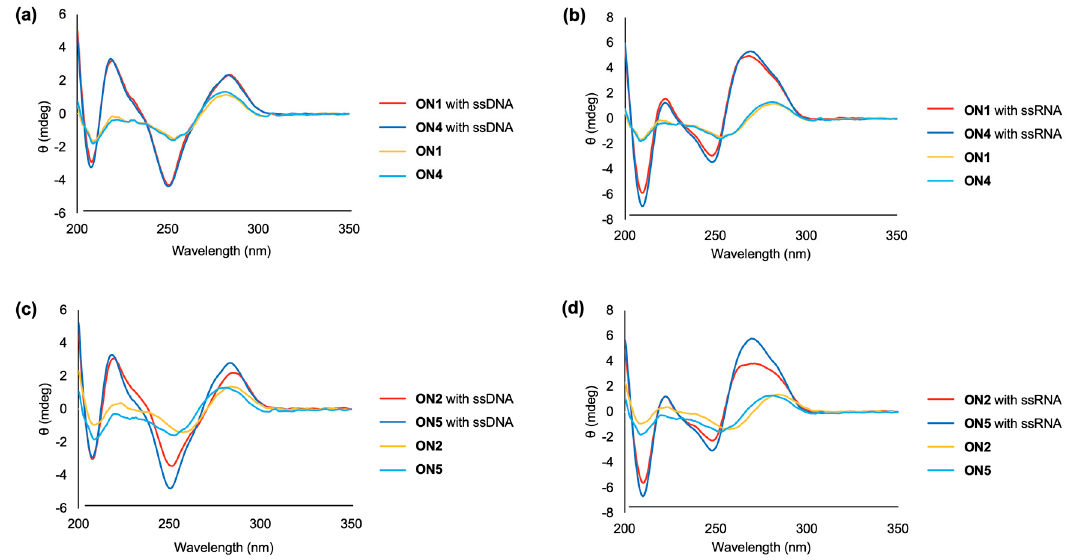
Figure 4. Circular dichroism (CD) spectra of OxNorNA-modified oligonucleotides ( ON1 and ON2 ) and their natural counterparts ( ON4 and ON5 ) in the presence or absence of a complementary strand (ssDNA or ssRNA). ( a ) ON1 and ON4 in the presence or absence of ssDNA; ( b ) ON1 and ON4 in the presence or absence of ssRNA; ( c ) ON2 and ON5 in the presence or absence of ssDNA; ( d ) ON2 and ON5 in the presence or absence of ssRNA. Conditions: 10 mM sodium phosphate buffer (pH 7.2) containing 100 mM NaCl and 4 μ M of each oligonucleotide at 10 °C. The sequences of the target ssDNA and ssRNA are 5’-d(AGCAAAAAACGC)-3’ and 5’-r(AGCAAAAAACGC)-3’, respectively.